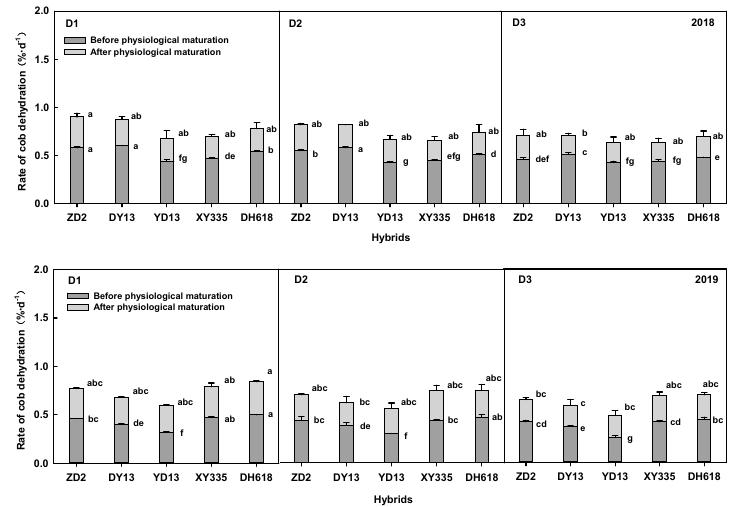
Figure 6. Dehydration rate of cobs of different hybrids under different densities in 2018 and 2019. Different letters on the graph indicate significant differences at p < 0.05.